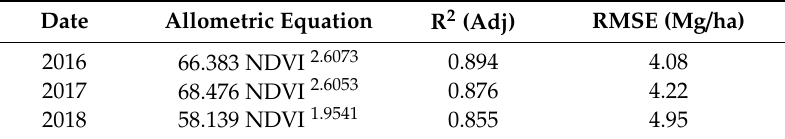
Table 5. Allometric equations adjusted for the 3 years in analysis.